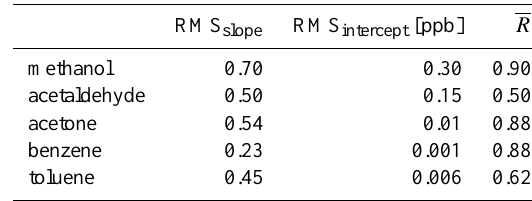
Table 4. Root mean square (RMS) differences of the scatter plot slopes from 1 : 1 line (RMS slope ), RMS of the intercepts (RMS intercept ) and mean correlation coefficient values R for the measured